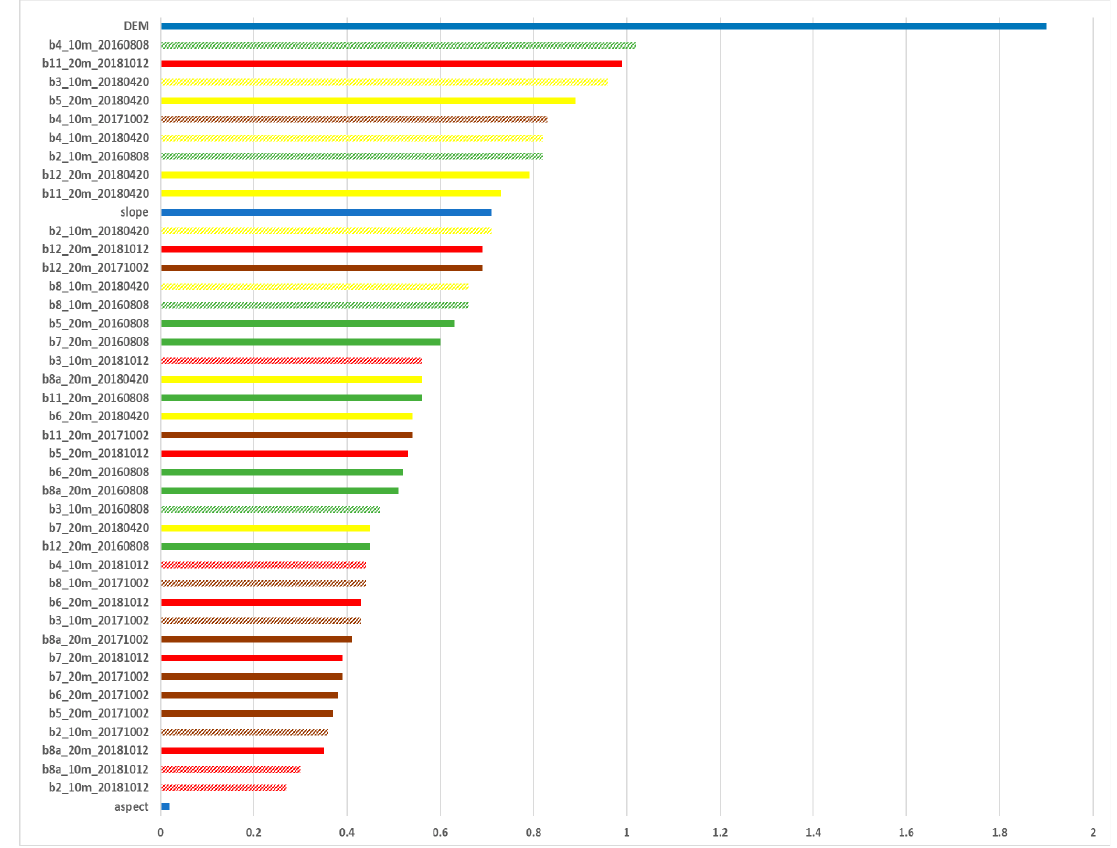
Figure 9. The normalised variable importance for the coniferous tree species classified using the combination of multi-temporal Sentinel-2 data and topographic features: SRTM DEM, slope and aspect. The variables are coloured according the Sentinel-2 acquisitions: Yellow indicates Spring (20 April), green—Summer (8 August), brown—early Autumn (2 October), red—mid-Autumn (12 October) and blue indicates topographic features. The solid colours refer to 10 m spatial resolution bands and the dash pattern refers to 20 m spatial resolution bands.